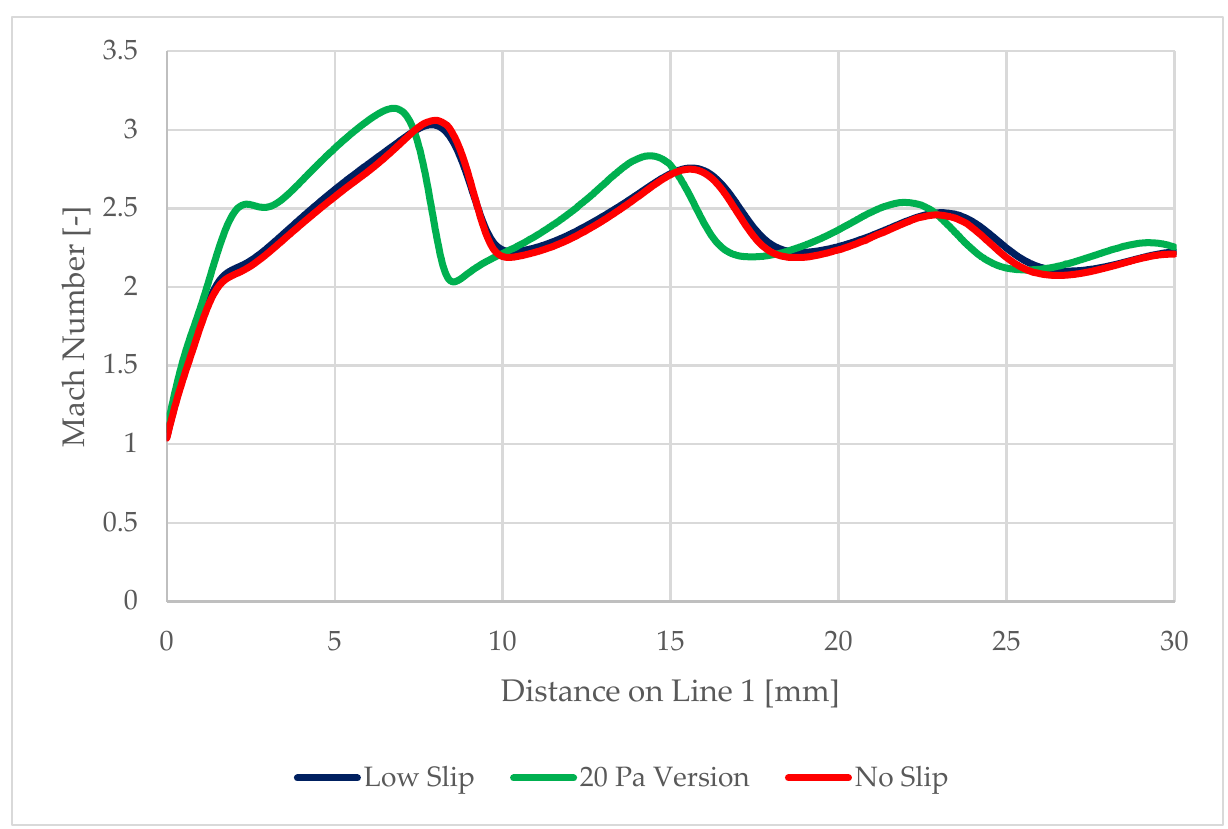
Figure 19. Mach number evolution on Line 1.